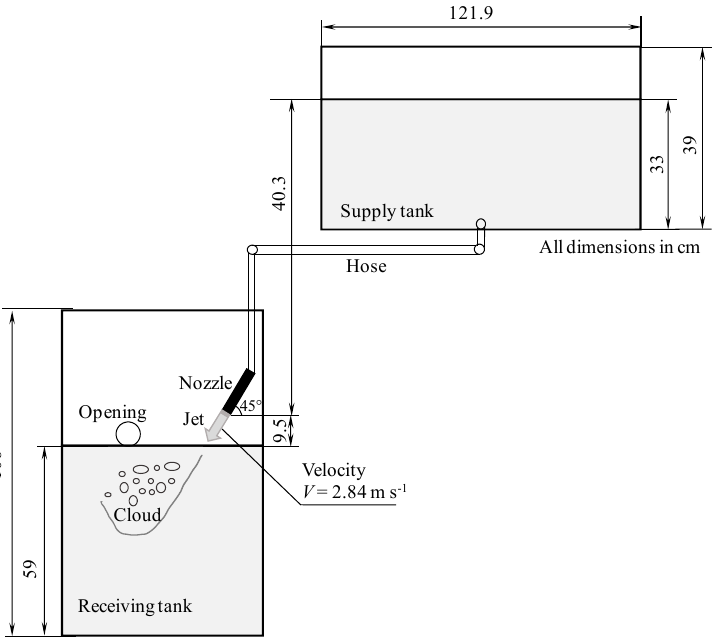
Figure 1. Schematic of the experimental setup. The differential head is h = 40.3 cm; jet impacts the water from a distance l = 9.5 cm. All measures are in cm.